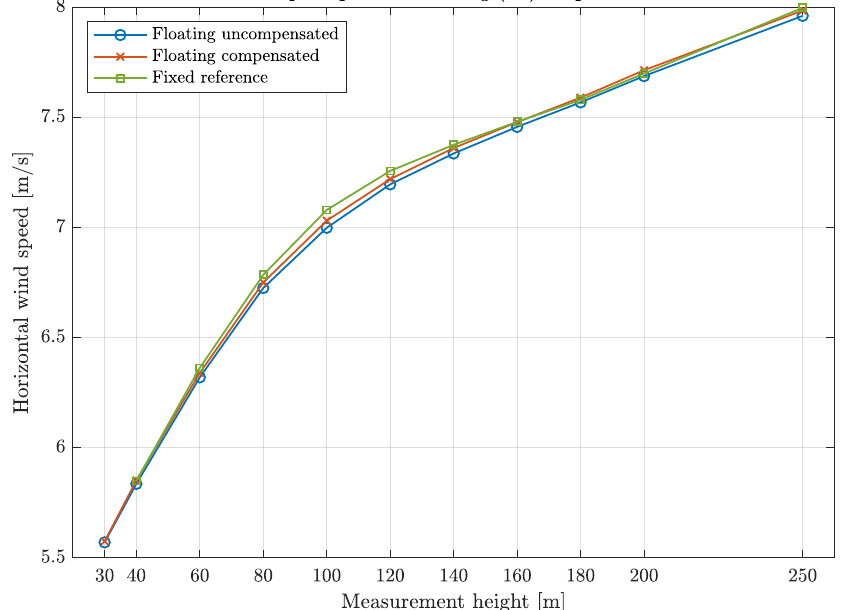
Figure 7. Average of measured horizontal mean wind velocities from the floating lidar with (red) and without (blue) motion compensation, as well as from the fixed reference lidar (green), sorted by measurement